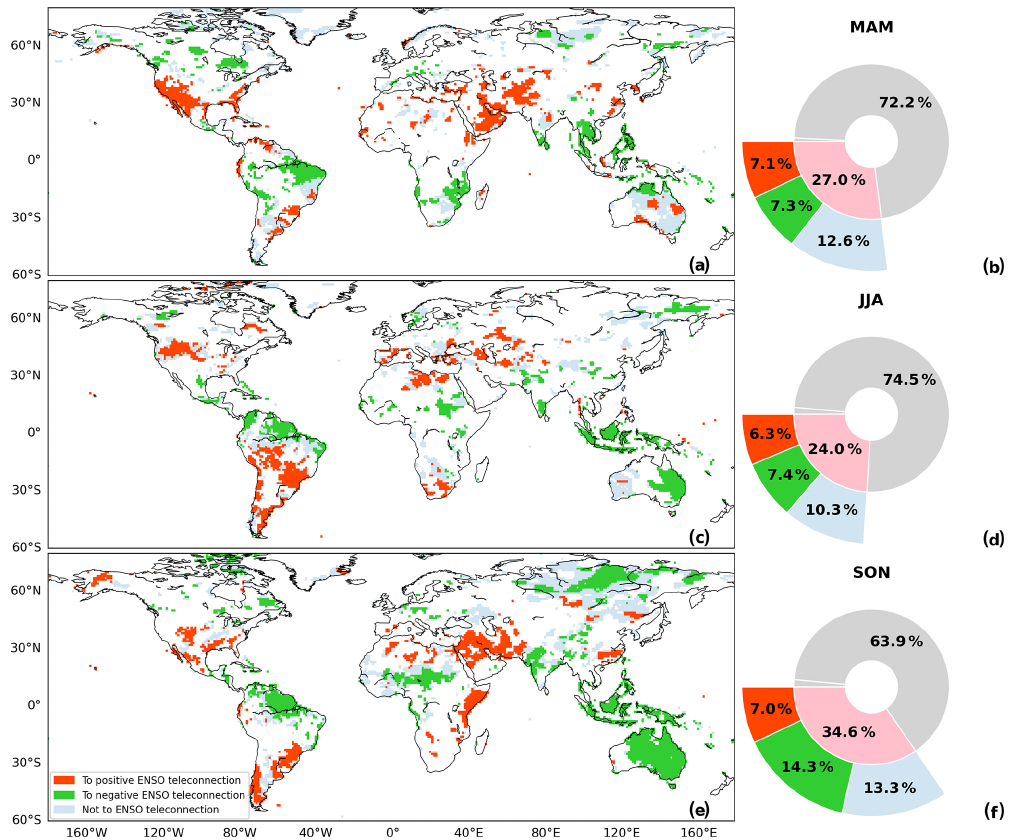
Figure 9. Spatial maps (a–c) and sunburst diagrams (d–f) of the three cases of attribution of significantly positive anomaly correlation in MAM (a, b) , JJA (c, d) and SON (e, f)